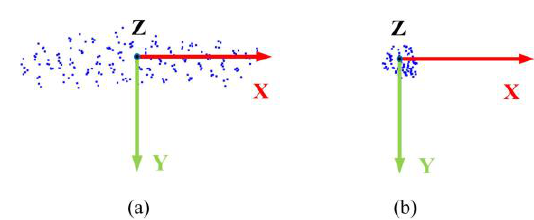
Figure 4. Spatial distribution of points in sections of a) toeboard and b) tube.